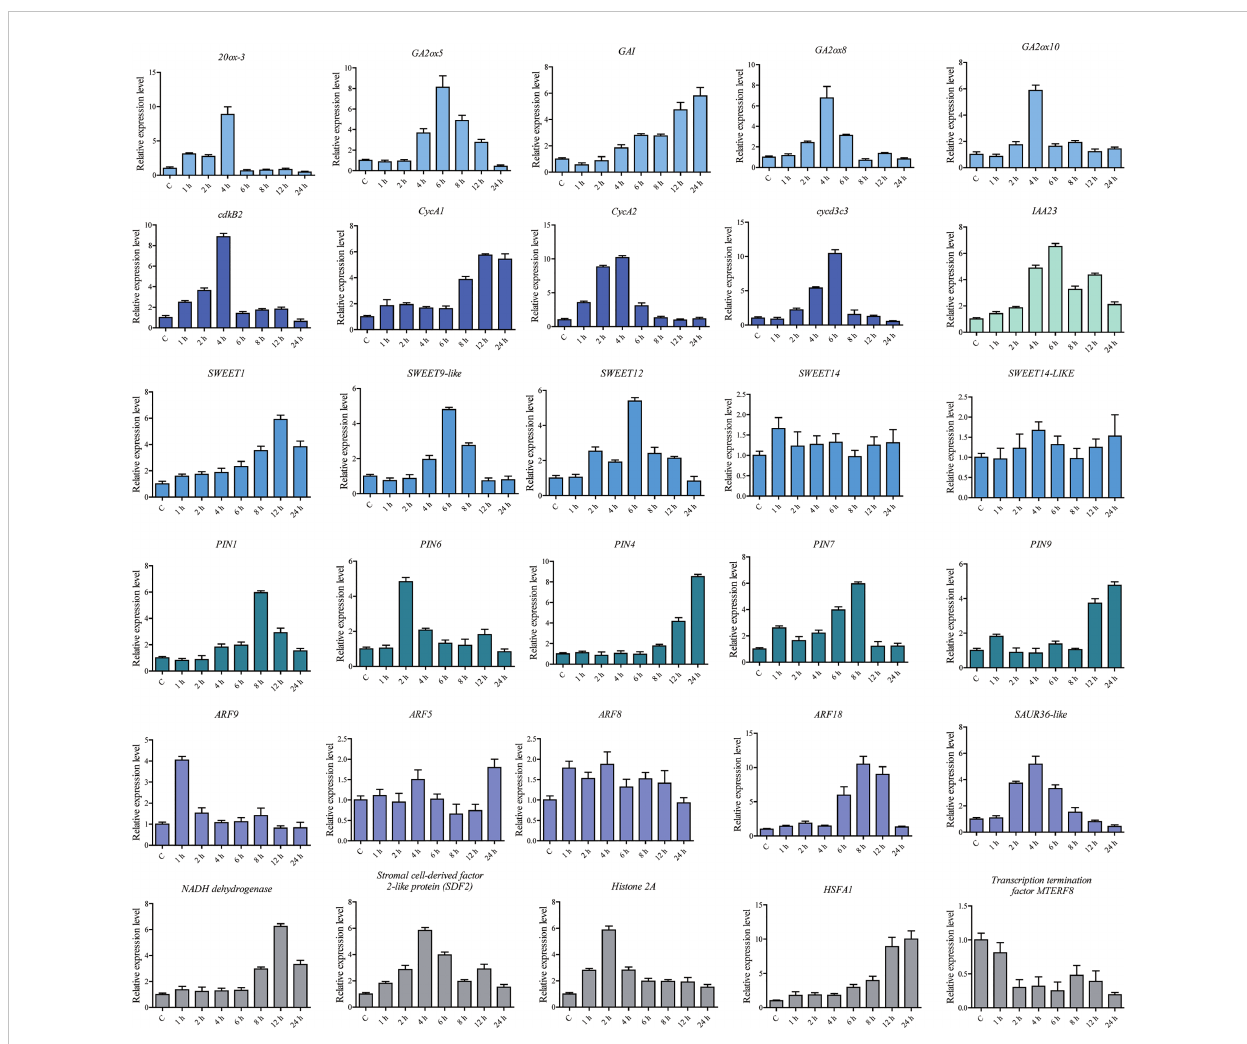
FIGURE 5 Relative expression levels of DEGs and DEPs analyzed using qPCR under the abaxial leafy supplemental lighting (AB) treatment. The relative expression level of each gene was calculated relative to the expression in the respective untreated control samples (0 h). Solanum lycopersicum Sly- Actin ( Solyc11g005330.2 ) was used as an internal control to normalize the expression data. Different colors represent genes in different signaling pathways. The error bars represent the standard deviation calculated based on three biological